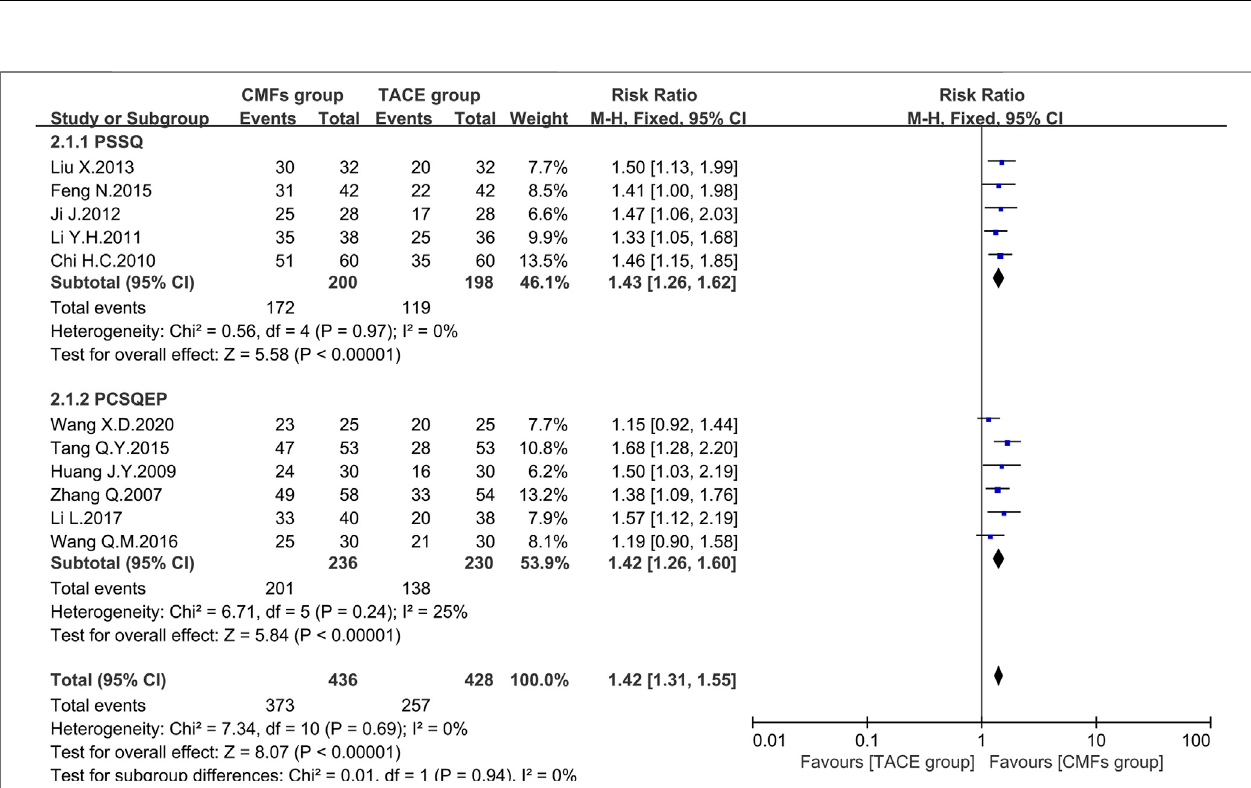
FIGURE 5 | Effect of CMFs group versus TACE group on the ef fi cient rate of KPS, including a comparison between PSSQ and PCSQEP in the subgroup.